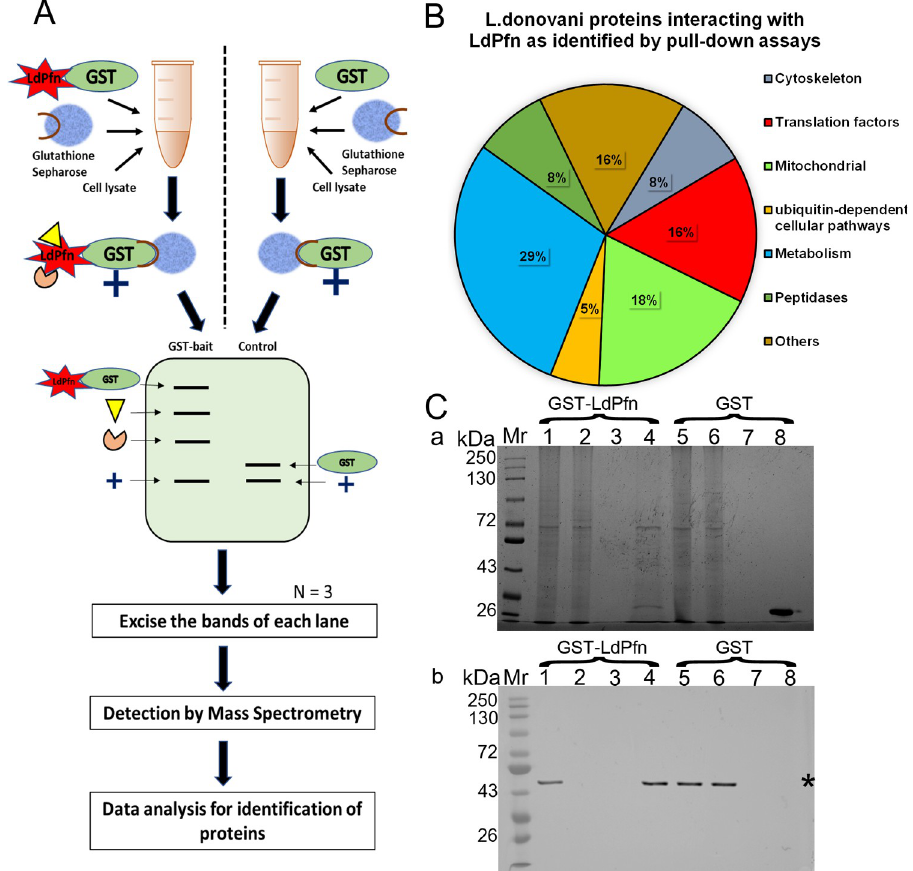
Fig 1. Pull-down assay, mass spectrometry analysis, and validation with western blot. (A) Schematic representation of the experimental design. (B) Pie chart showing the total number of GST-profilin ligands (38 proteins) grouped according to their deduced function or cellular location. The percent of proteins in each group has been labelled as Cytoskeleton (8%), Translation factors (16%), Mitochondrial (18%), Ubiquitin-dependent cellular pathways (5%), Metabolism (29%), Peptidases (8%), and Others (16%). (C) Validation of Proteomics results with western blot analysis. (a) Silver-stained 12% polyacrylamide gel. Mr, molecular weight markers; lanes 1–4 correspond to GST- Leishmania profilin (GST-LdPfn) pulldown: lane 1, Input lysate; lane 2, unbound fraction; lane 3, wash fraction; lane 4, GST-LdPfn pulldown eluate; lanes 5–8 correspond to GST- alone pulldown: lane 5, Input lysate; lane 6, unbound fraction; lane 7, wash fraction; lane 8, GST-alone pulldown eluate. (b) Western blot of lanes 1 to 8 from ‘a ’ with anti-eIF4A-1 antibodies. Asterisk marks the band corresponding to eIF4A-1 protein (45.3